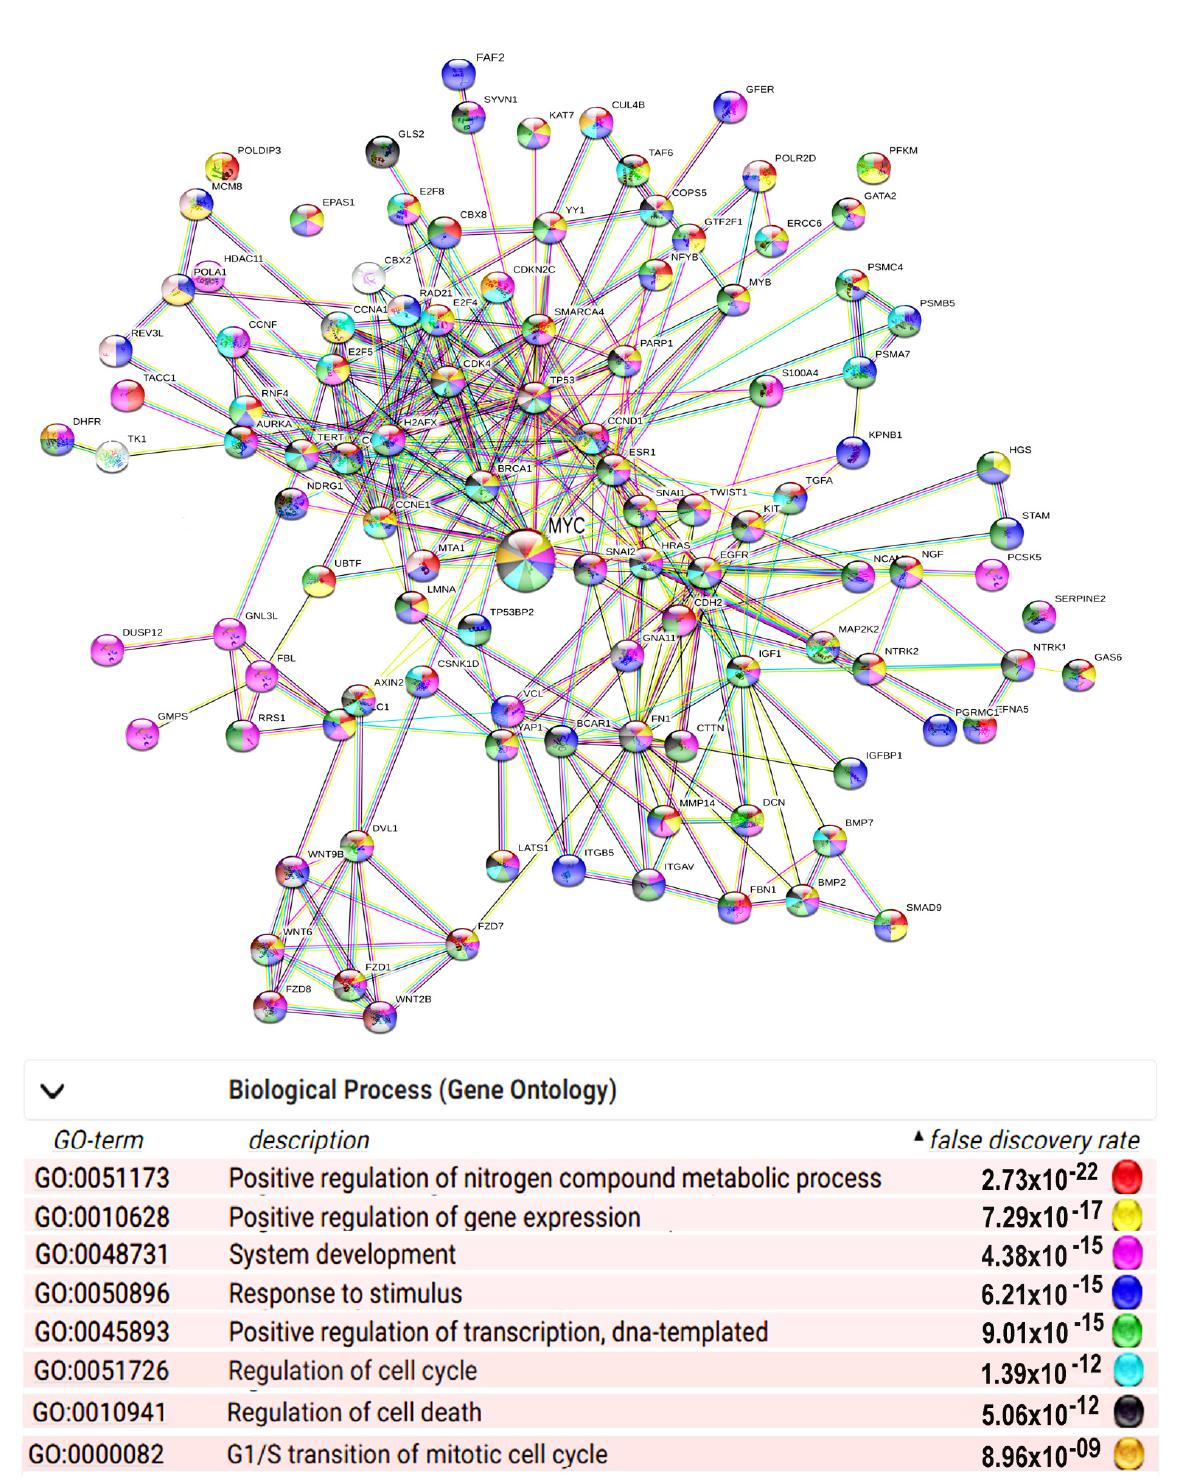
Figure 1. The most connected component of protein interaction networks of significantly ploidy- induced genes in the c-Myc interactome of human and mouse heart, liver, and placenta. The network was constructed using the String server (https://string-db.org/, assessed on 5 May 2022). The data for network construction were taken from [72]. Color coding reflects the Biological Process of Gene Ontology (GO) database. The gene symbols containing portions of various colors indicate that a gene is involved in several GO biological processes. The fraction of a circle that is a particular color does not convey any meaning; the circle is simply divided into a number of partitions to reflect the number of GO processes